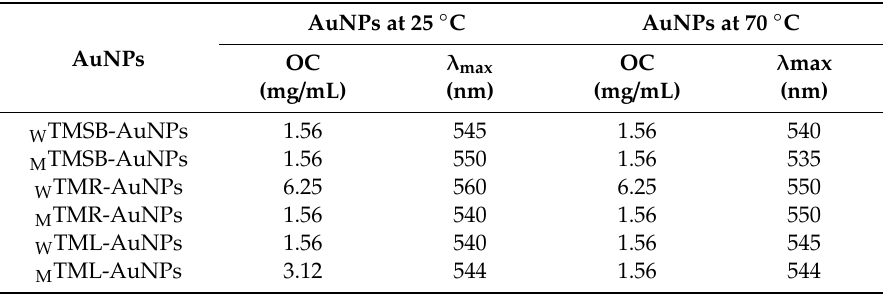
Table 2. The OC of TM extracts for AuNP synthesis and the SPR of TM-AuNPs. AuNPs at 25 ◦ C AuNPs